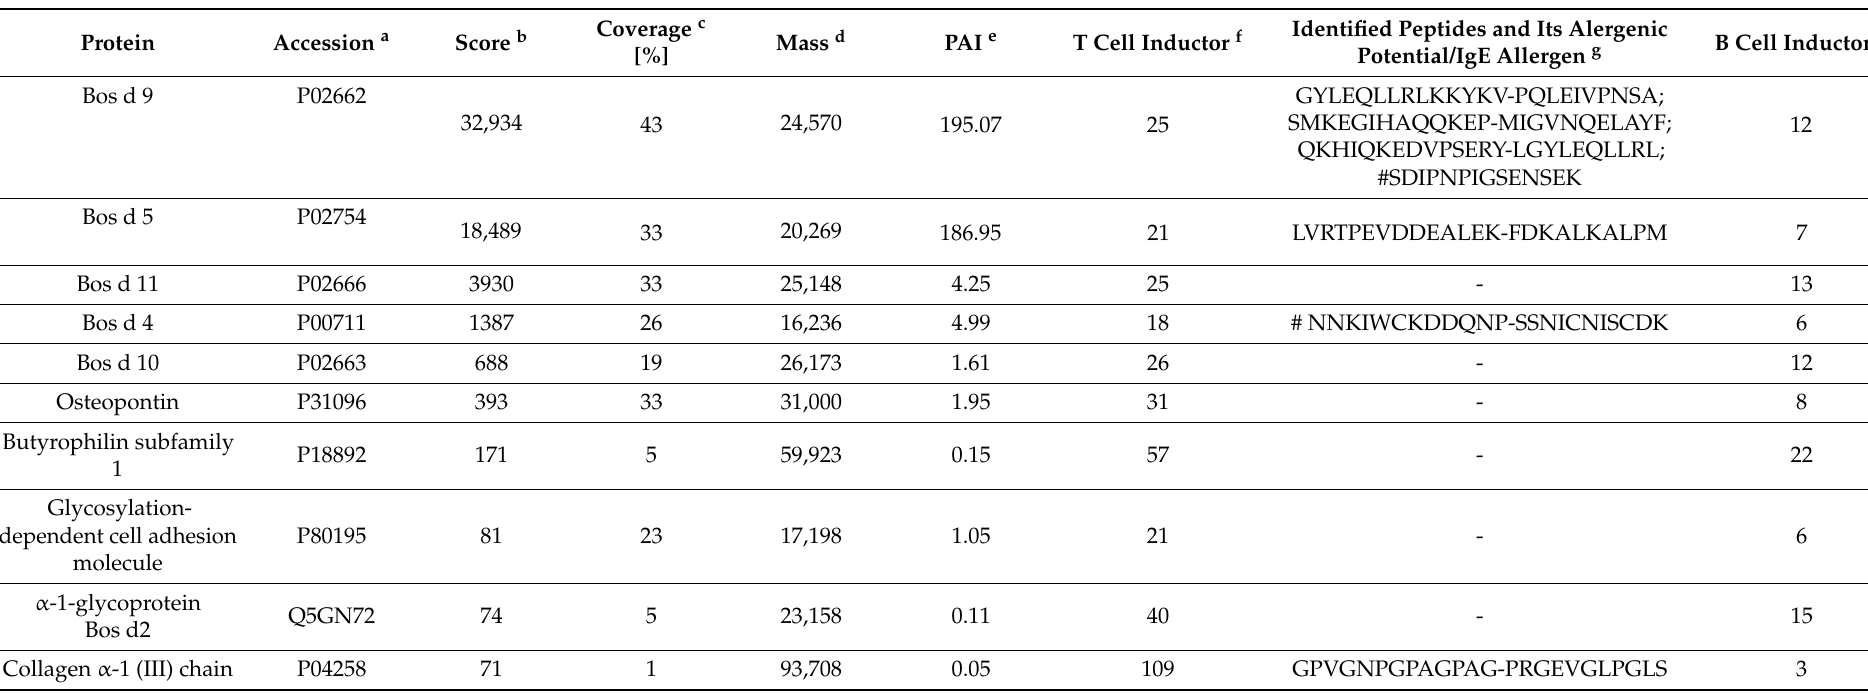
Collagen α -1 (III) chain